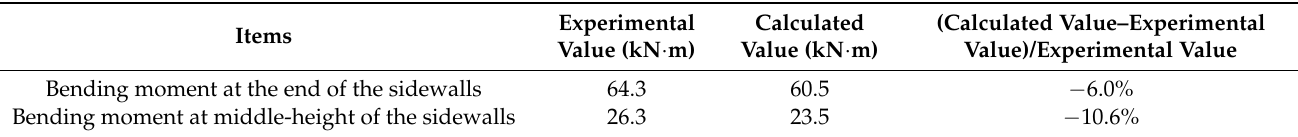
Table 2. Comparison of calculated values and experimental